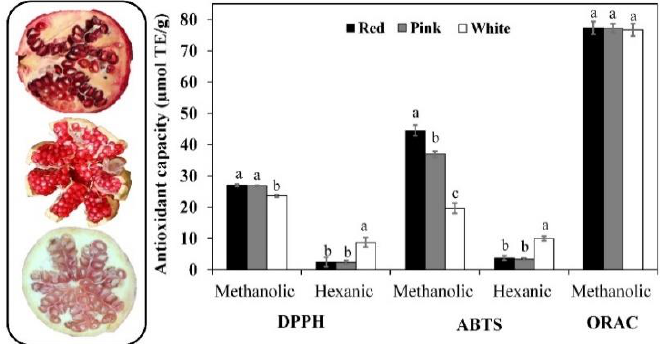
Figure 1. Antioxidant capacity of red (CV. Wonderful), pink (cv. Molar de Elche), and white (cv. Indian) pomegranates fruits. Results are expressed as mean [μmol of Trolox equivalents (TE)/g of dried fruit (methanolic extract) or seed oil (hexane extract)] ± standard deviation (SD). Different letters for the same antioxidant assay signified statistical differences ( p < 0.05). 2,2 ’ -Azino-bis(3-ethylbenzothiazoline-6-sulfonic acid (ABTS), 2,2-diphenyl-1-picrylhydrazyl (DPPH), Oxygen radi- cal absorbance capacity (ORAC) are displayed.